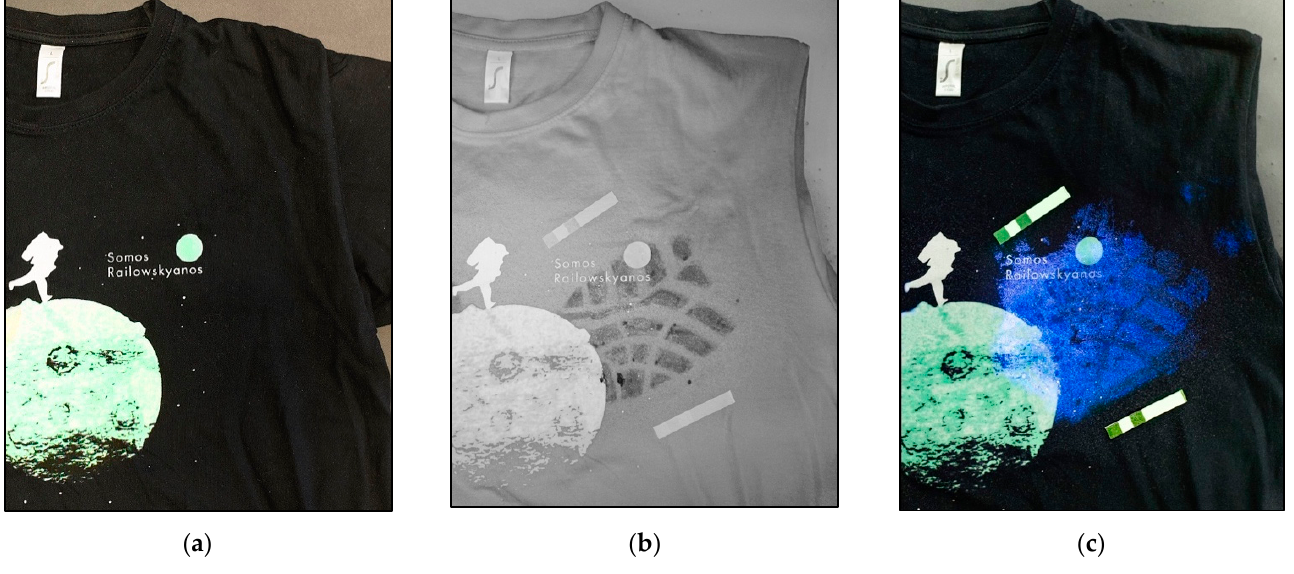
Figure 4. Images of black cotton shirt with traces of latent blood photographed ( a ) with conventional camera and illuminated with white visible light, ( b ) by Invespector illuminated with IR radiation 850 nm and ( c ) after applying a chemo locator, such as